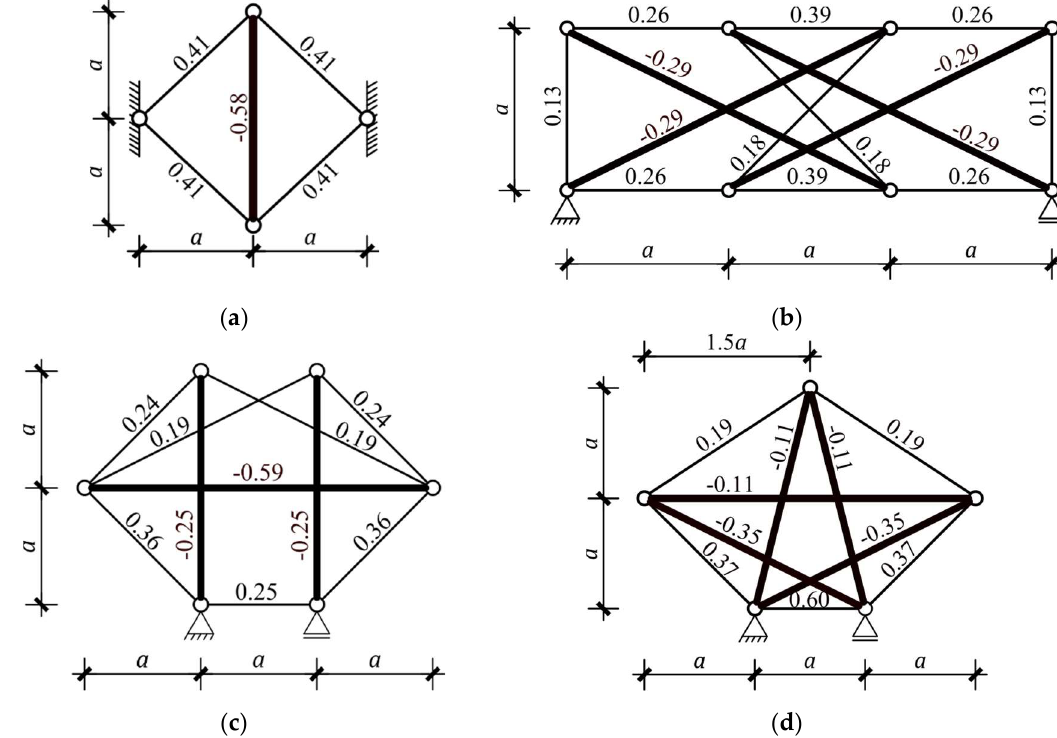
Figure 4. Self-stress values for fourtrusses ( a - d ) with tensegrity features.